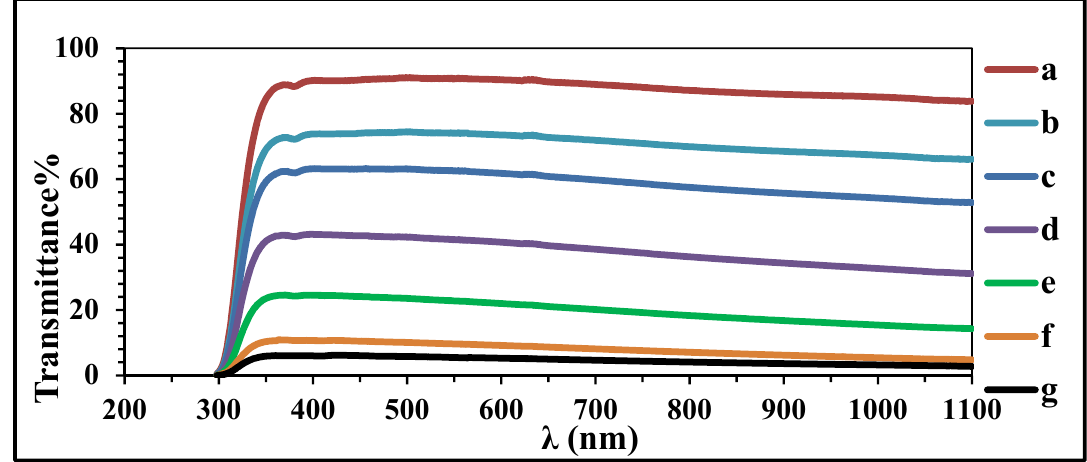
Fig. 4: Optical the transmittance for solid films of PVA\CuI polymer composites with different concentrations of CuI. (a) 0wt% (b) 1wt% (c)3wt% (d)5wt% (e)7wt% (f)9wt% (g)20wt%.